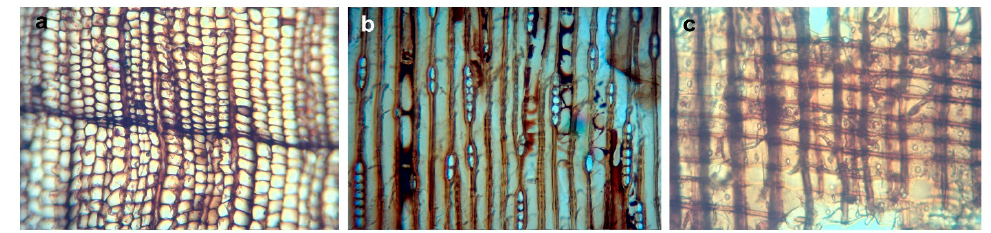
Figure 6. Microphotographs of wood sections under the microscope in transmitted light showing the anatomical characteristics of juniprus sp.: ( a ) transverse section (TS); ( b ) tangential longitudi-nal section (TLS); ( c ) radial longitudinal section (RLS).